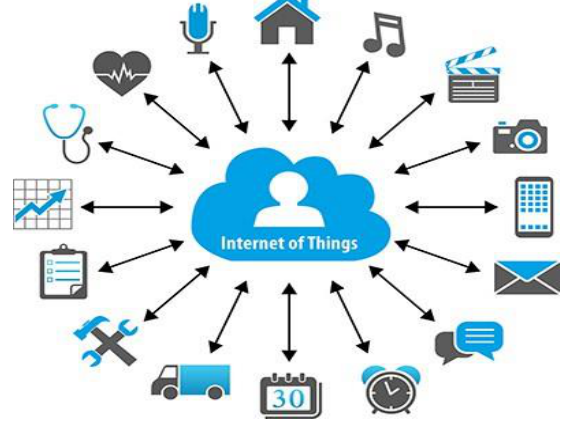
Figure 1. Importance of